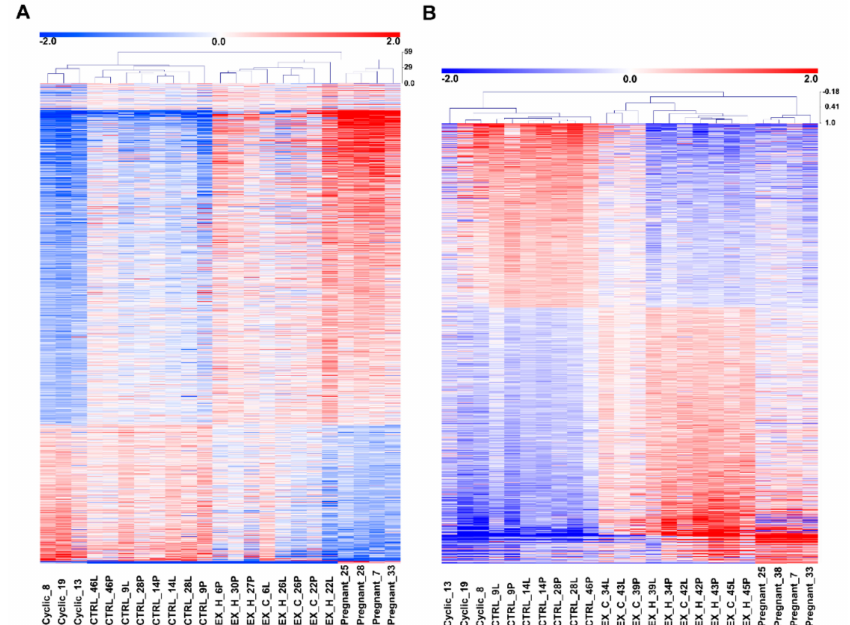
Figure 2. Comparison of transcriptome changes detected in endometrial samples collected from gilts on day 12 of the estrous cycle and pregnancy with the e ff ect of intrauterine estradiol-17 β administration ( A : 833 ng of E2 / infusion; B : 33.3 µ g of E2 / infusion). Data are shown as a heatmap of hierarchical clustering (Pearson correlation) of the normalized values of the intensity of the expression signals of probes detected as significantly changed (log fold change > 0.585; p nominal < 0.05 false discovery rate (FDR) = 5%) in analyzed groups. Cyclic-endometrial samples collected on day 12 of the estrous cycle, pregnant-endometrial samples collected on day 12 of pregnancy, control-endometrial samples collected from gilts assigned to control groups (infusions of placebo to both uterine horns), EX_H-endometrial samples collected from gilts assigned to the experimental group (uterine horns receiving E2 infusions), EX_C-endometrial samples collected from gilts assigned to experimental group (uterine horns receiving placebo